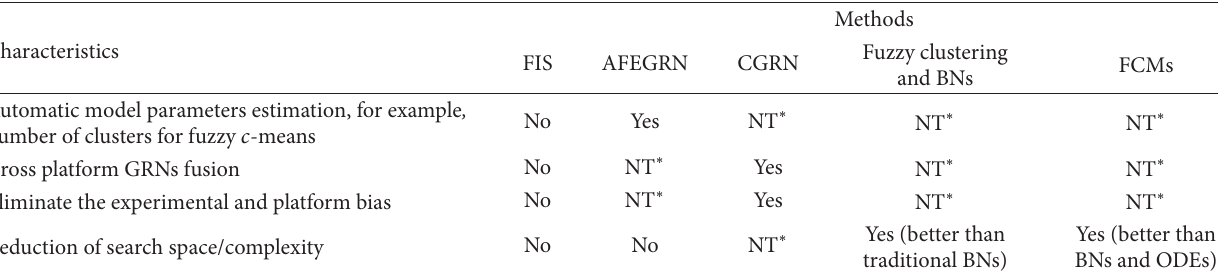
Table 3: Comparison of FIS versus other hybrid methods.